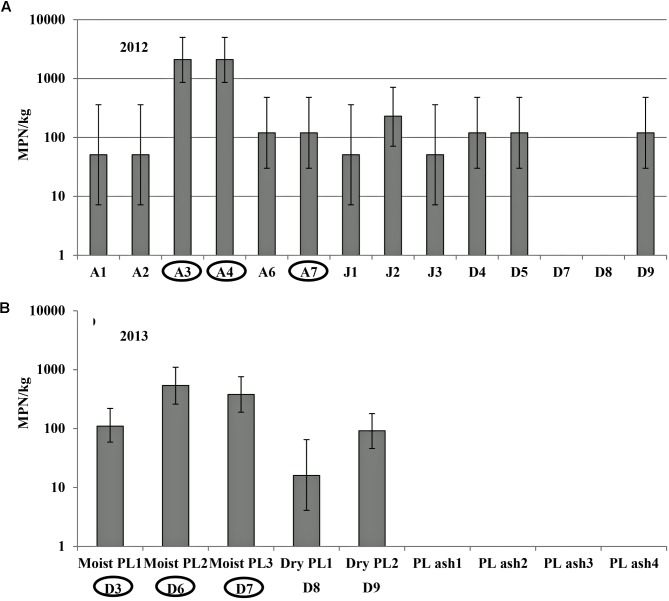
Salmonella population density (MPN/kg) in poultry litter (PL) samples in different broiler farms tested in 2012 (A) and in different PL and PL ash samples in 2013 (B). Letters represent different chicken farms, and numbers behind represent different chicken houses in each farm. PL samples were collected from 14 chicken houses in 3 broiler farms in 2012 (A). In 2013, moist and dry PL was sampled from 5 chicken houses in broiler farm D. PL ash was collected from 4 factories for Salmonella detection (B). Fresh PL was collected from the circled chicken houses for soil amendment in 2012 (A) and 2013 (B) field trials of experiment 2. Bars represent 95% confidence intervals of Salmonella MPN values of tested samples.